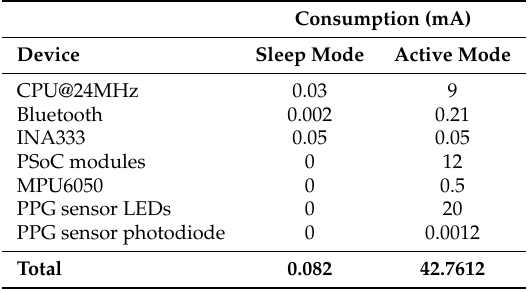
Table 3. Power consumption summary for the presented